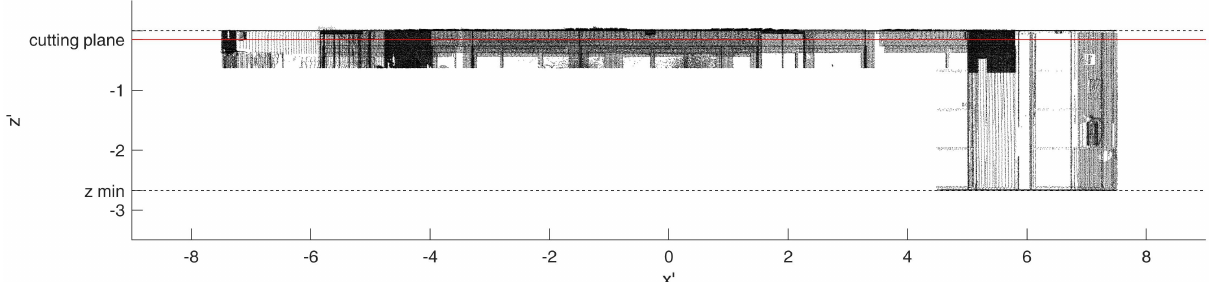
Figure 3: Vertical section of the input point cloud and determination of the room heigth ( h = | z min | ).